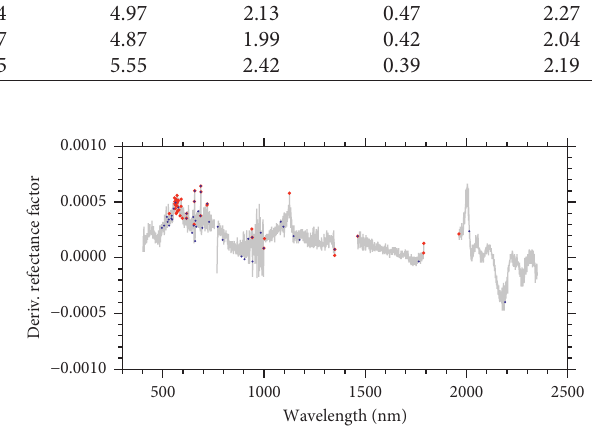
Table 1: Descriptive statistics of SOC (in g 100g − 1 ) values within the whole, calibration, and validation datasets. Dataset N